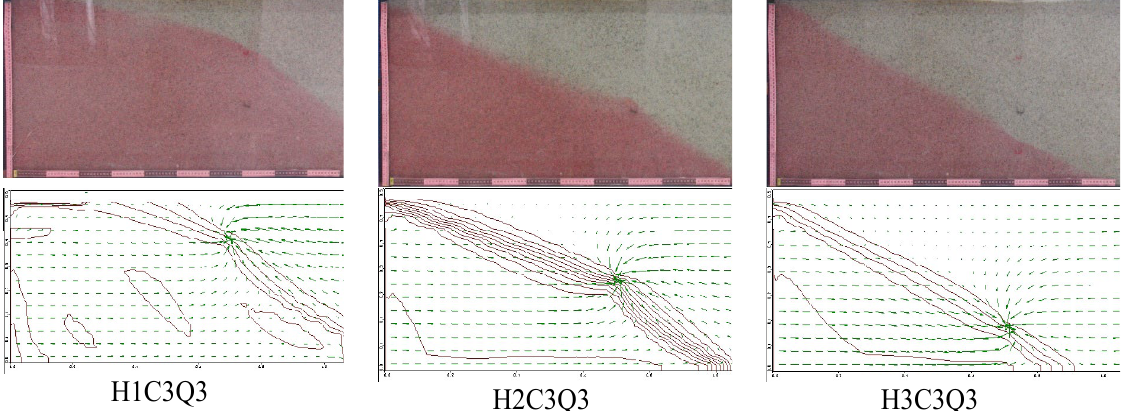
Fig. 5: Final steady state condition in three different well depths in C3Q3 experiments